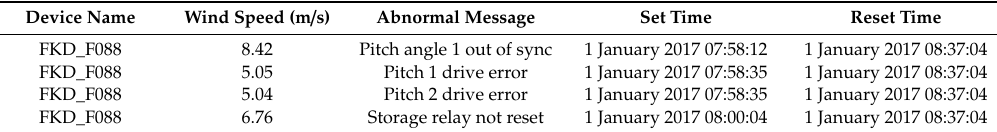
Table 2. Fault alarm records for the pitch system of the wind